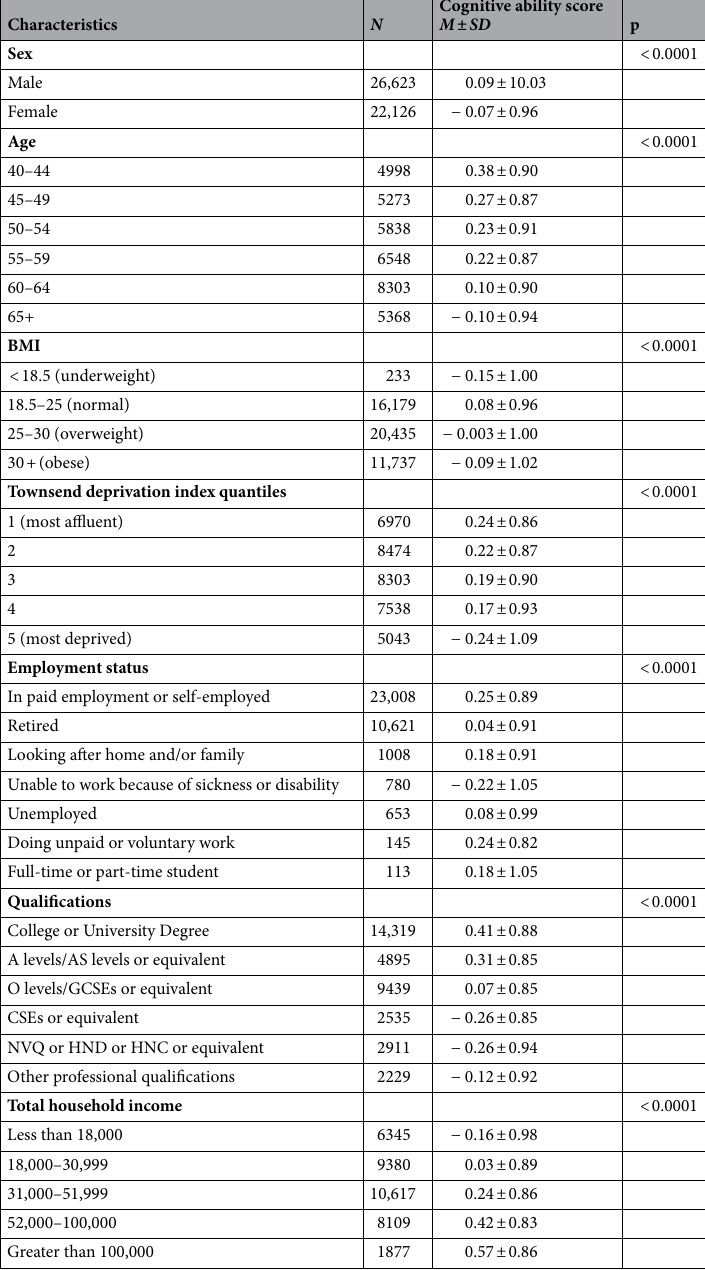
Table 2. Baseline characteristics of cognitive ability score ( n = 48,749). Independent samples t-test for sex, and separate one-way ANOVAs for the remainder of the characteristics were conducted for the comparisons between participant characteristics and cognitive ability